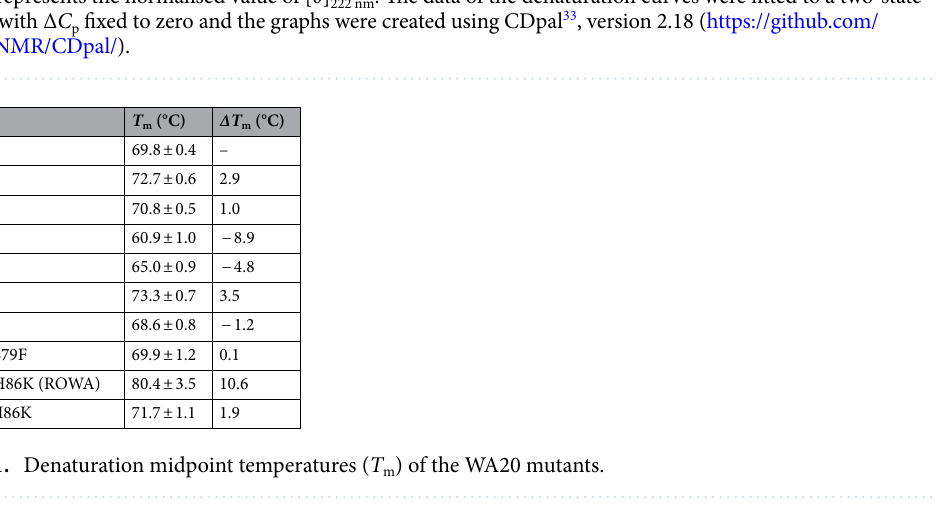
Fig. S4). The circular dichroism (CD) spectra at 25 °C showed that all of the mutants formed α-helical structures, as well as the parental WA20 protein (Fig. 2A and Supplementary Fig. S5). Thermal denaturation experiments (Table 1 and Supplementary Fig. S6) revealed that the N22A, N22E, and H86K mutants had higher midpoint temperatures than WA20 (Δ T m of 2.9 °C for N22A, 1.0 °C for N22E, and 3.5 °C for H86K). In contrast, the N22K and N22L mutations considerably reduced the stability (Table 1). To test combination of these stabilising mutations, we constructed two double mutants of WA20: N22A/ H86K and N22E/H86K. The N22A/H86K mutant (ROWA), remarkably improved the stability (Δ T m = 10.6 °C) compared with the parental WA20 protein (Fig. 2B and Table 1).